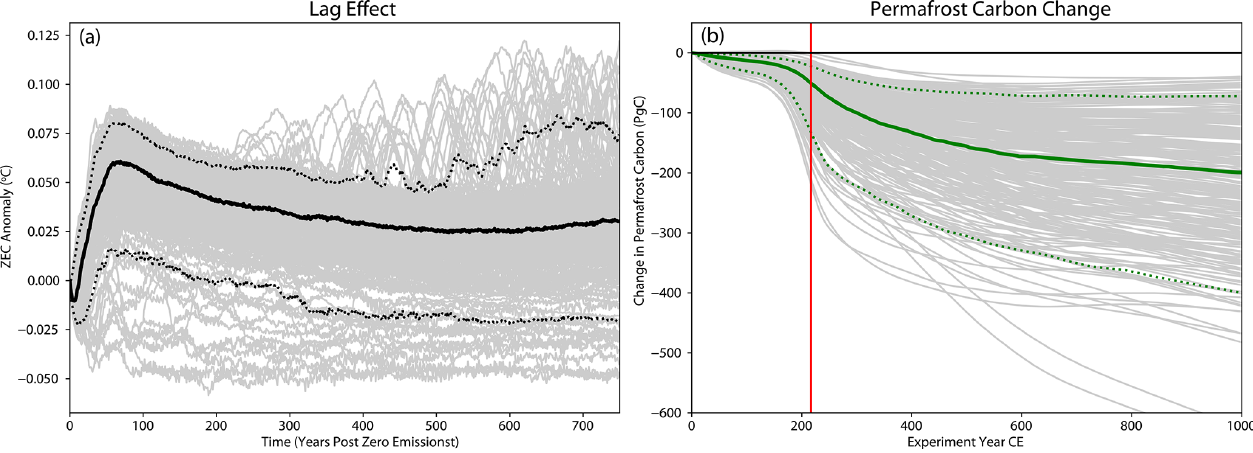
Figure 7. (a) Difference in ZEC between the SSP4-6.0-based 1000PgC experiment and the standard ZECMIP A1 (1000PgC) experiment. (b) Change in the soil carbon held in permafrost regions relative to pre-industrial size under the SSP4-6.0-based experiment. Vertical red line marks the time emissions cease. Grey lines are individual model variants, solid line is the median of the variants, and dashed lines are the 5th and 95th